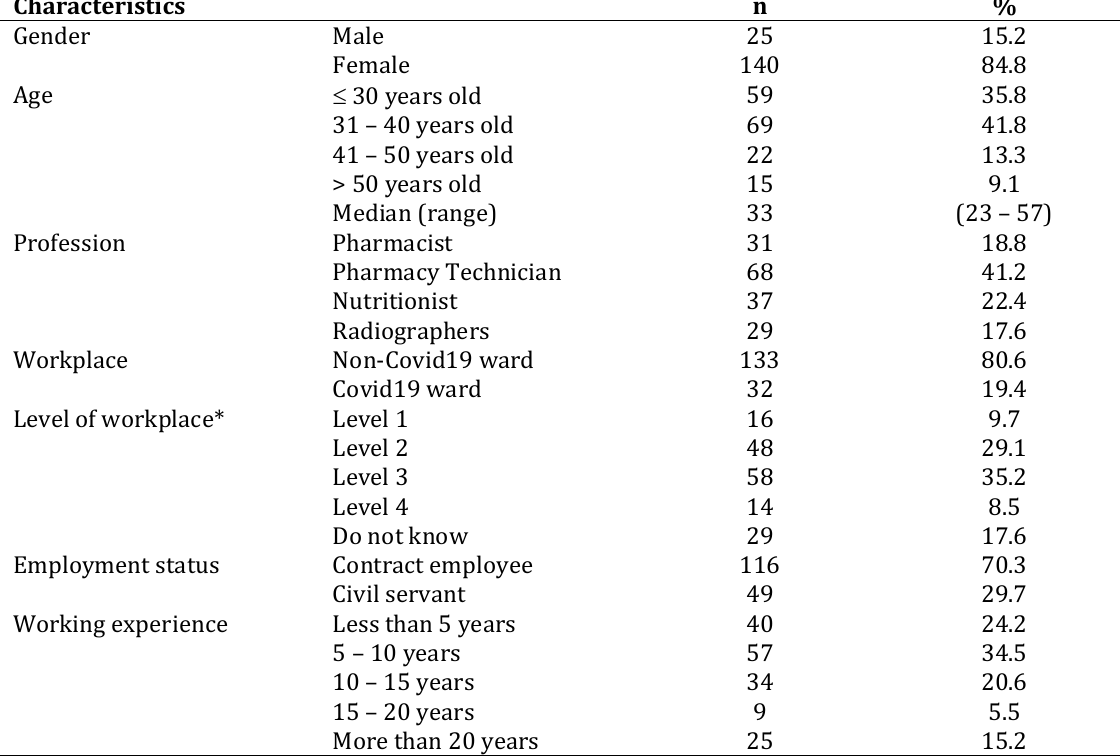
Table I. The Characteristics of Participants (N=165) Characteristics